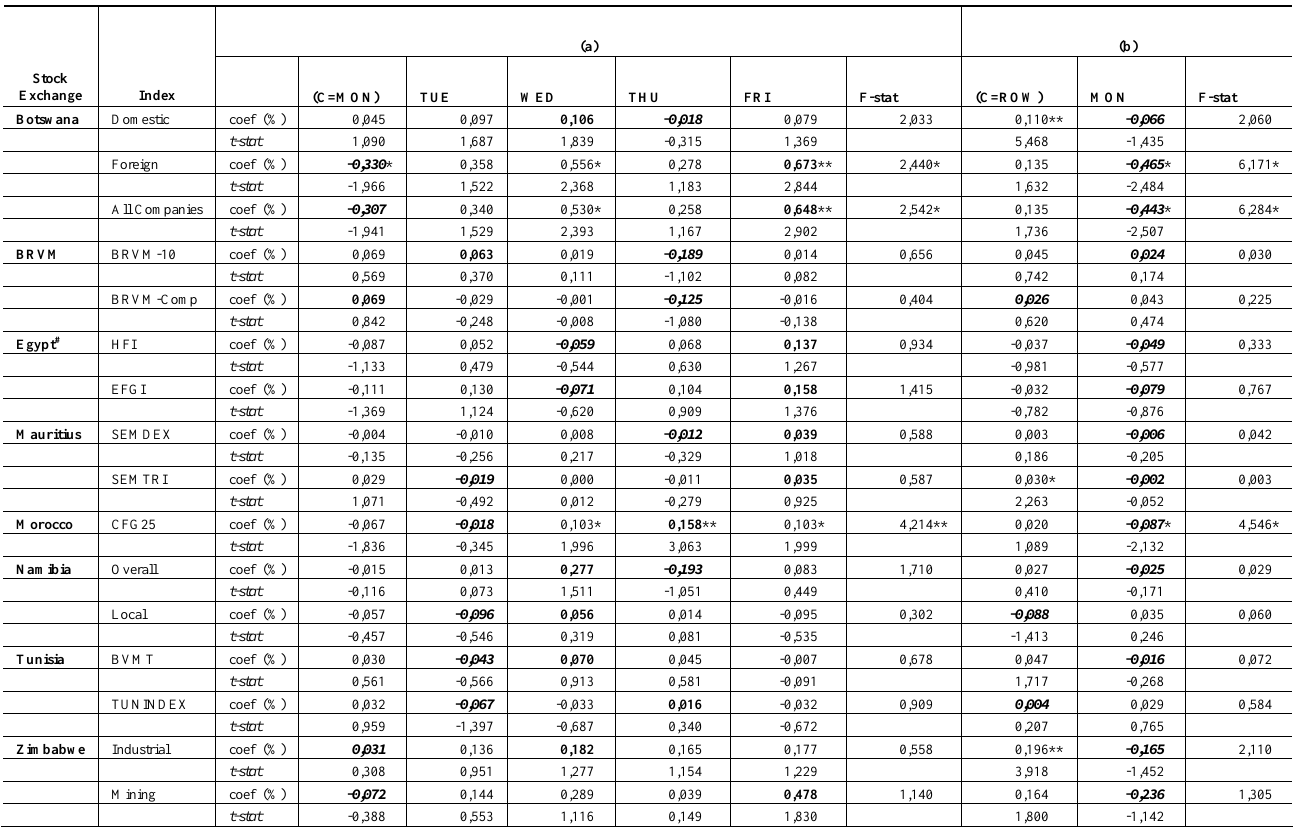
Table 2: Regression results for Day-of-the-Week/Monday Effect